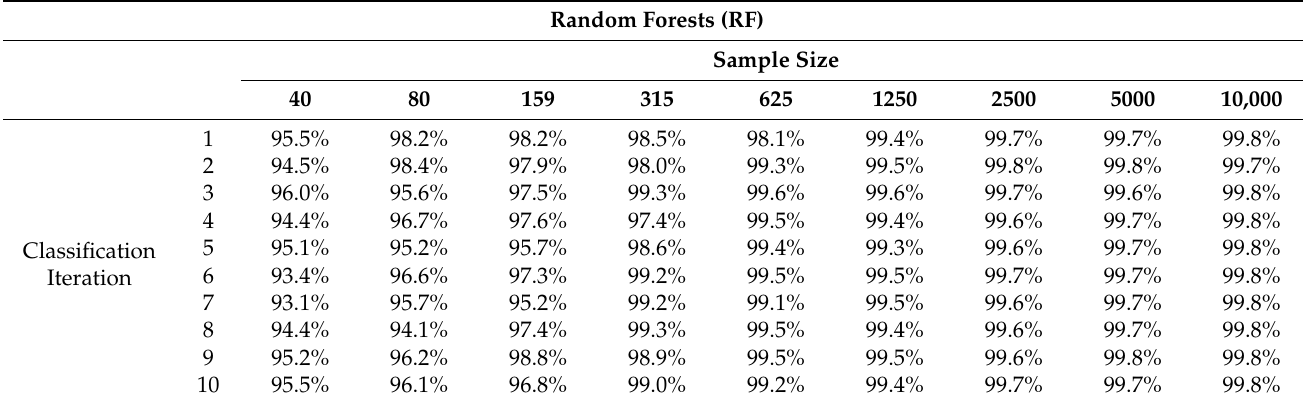
Table A2. Overall Accuracies of Random Forests (RF) Classifications.